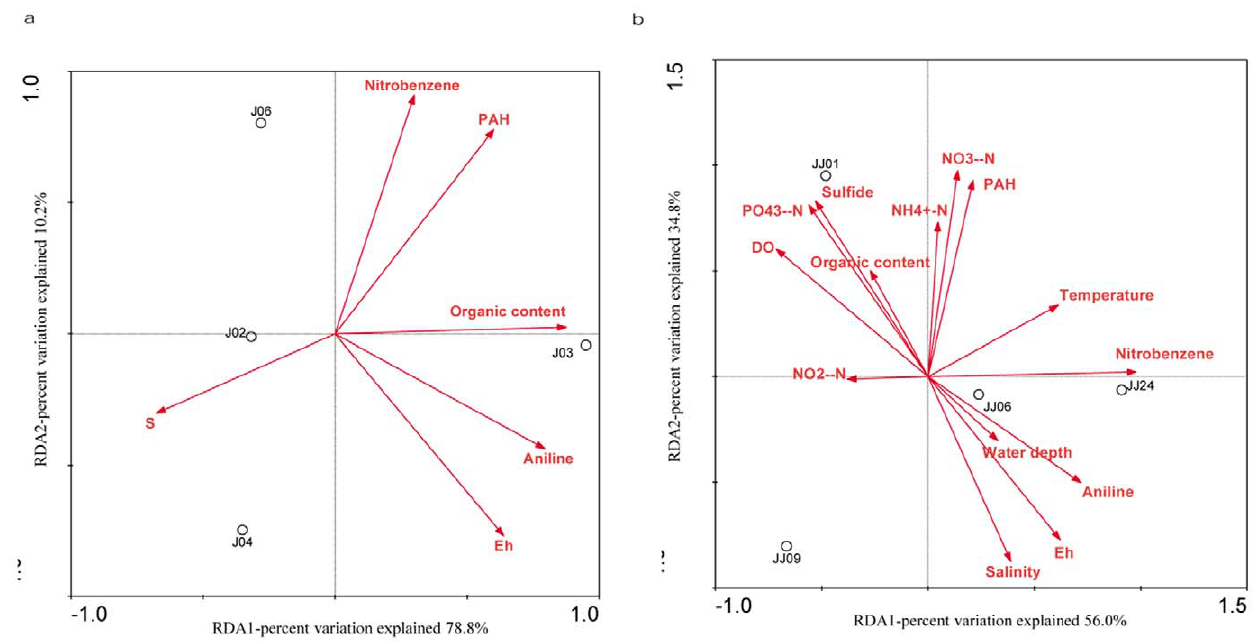
Figure 4. RDA ordination plots for the first dimensions showing the relationships between the anammox communities and environmental factors within the estuarine intertidal (a) and subtidal sediments (b). Correlations between environmental factors and RDA axes are represented by the length and angle of the arrows.